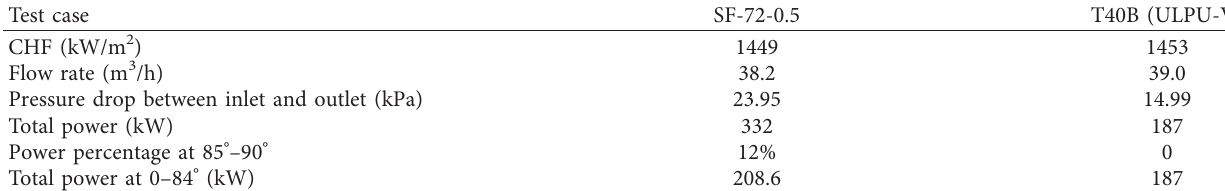
Table 3: Comparison of SF-72-0.5 and